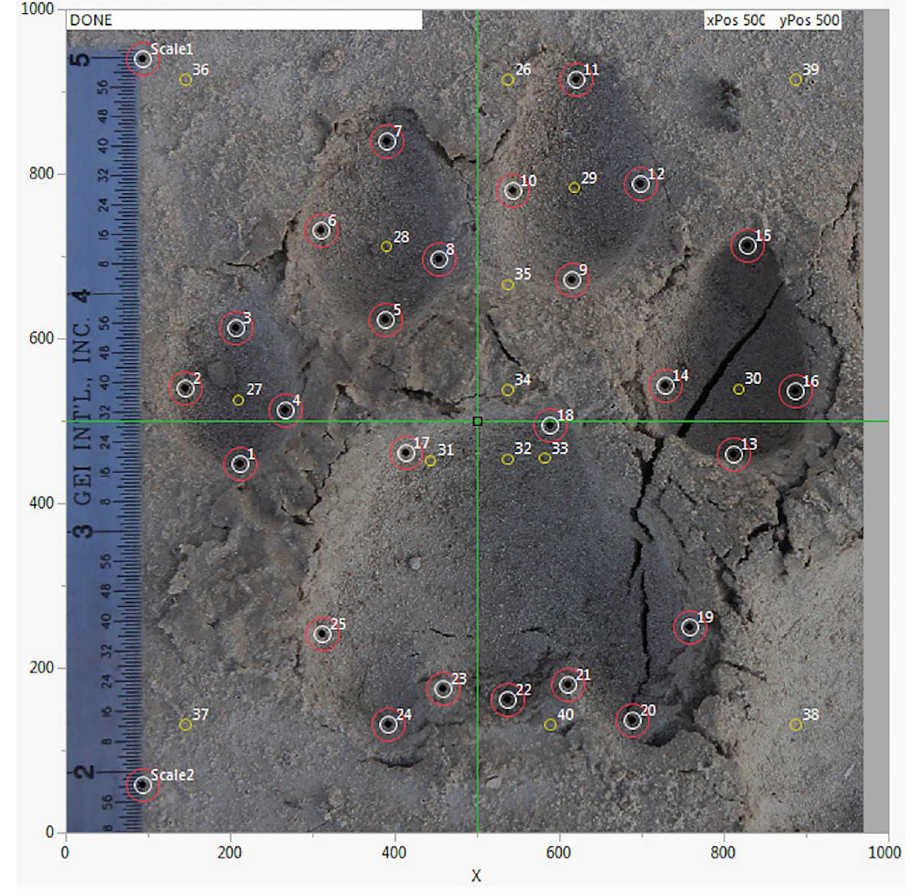
Fig 4. A puma footprint showing the placement of 25 landmark points (red circles) and 15 points derived from them and generated by the FIT script (yellow circles). The landmark points and derived points are numberedin one sequence,providing 40 total points from which measurements (variables)of the footprint are